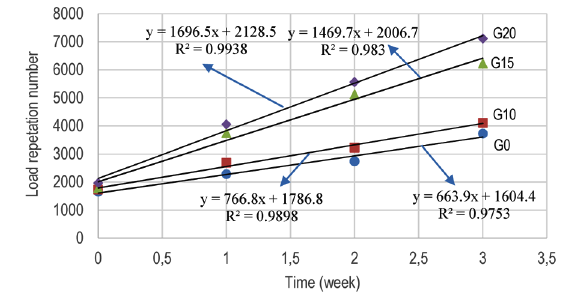
Fig. 8. The stiffness modulus (Sm) values of mixtures in aging conditions